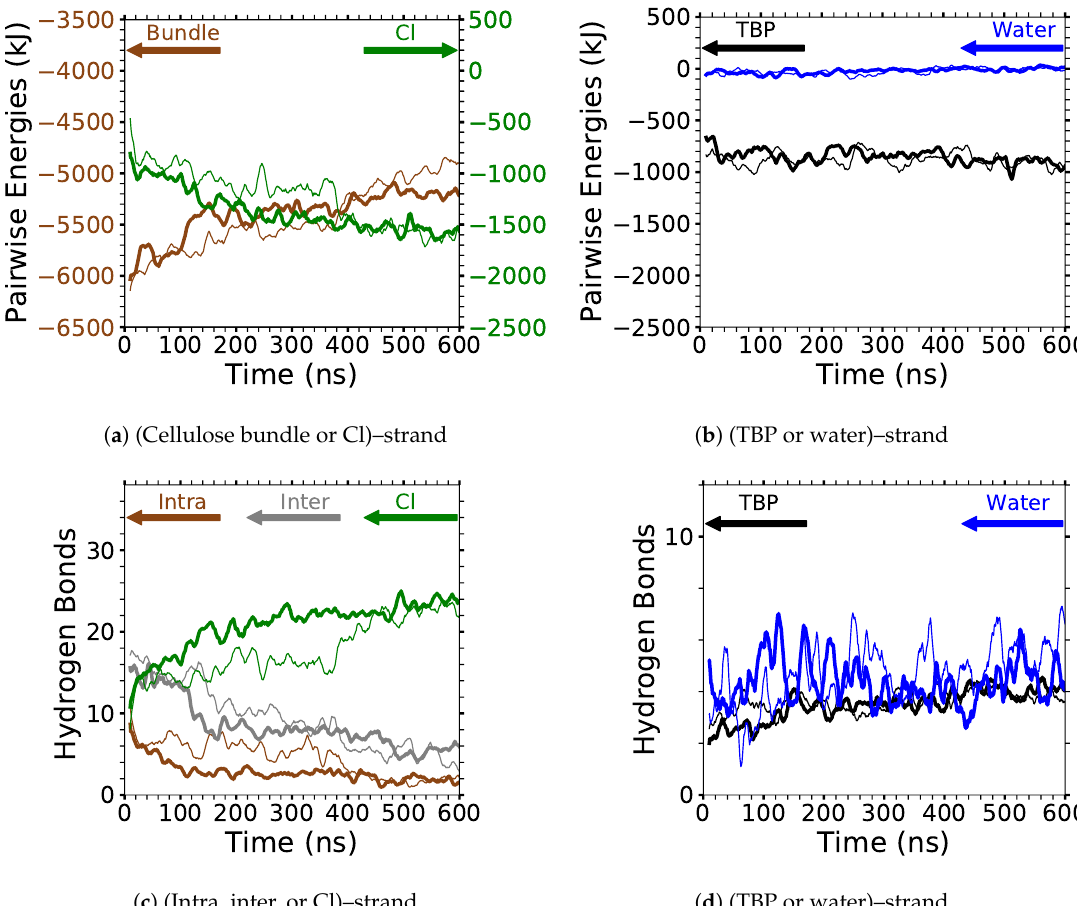
Figure A15. Pairwise energies and hydrogen bonding of the peeling strand(s) at 79.4mol%water and 360K. The pairwise energies of the separating strand(s) between the: ( a ) (cellulose bundle or Cl)–separating strand; ( b ) (TBP or water)–separating strand. The number of hydrogen bonds for the separating strand(s) per the given type: ( c ) (intra, inter, or Cl)–separating strand; ( d ) (TBP or water)–separating strand. The thick line is the first yellow strand to peel, and the thin line is the non-peeling yellow strand or second strand to peel. If neither of the stands peel, then both the thick and thin lines are non-peeling yellow strands. The data were averaged over 1000 data points, using a rolling